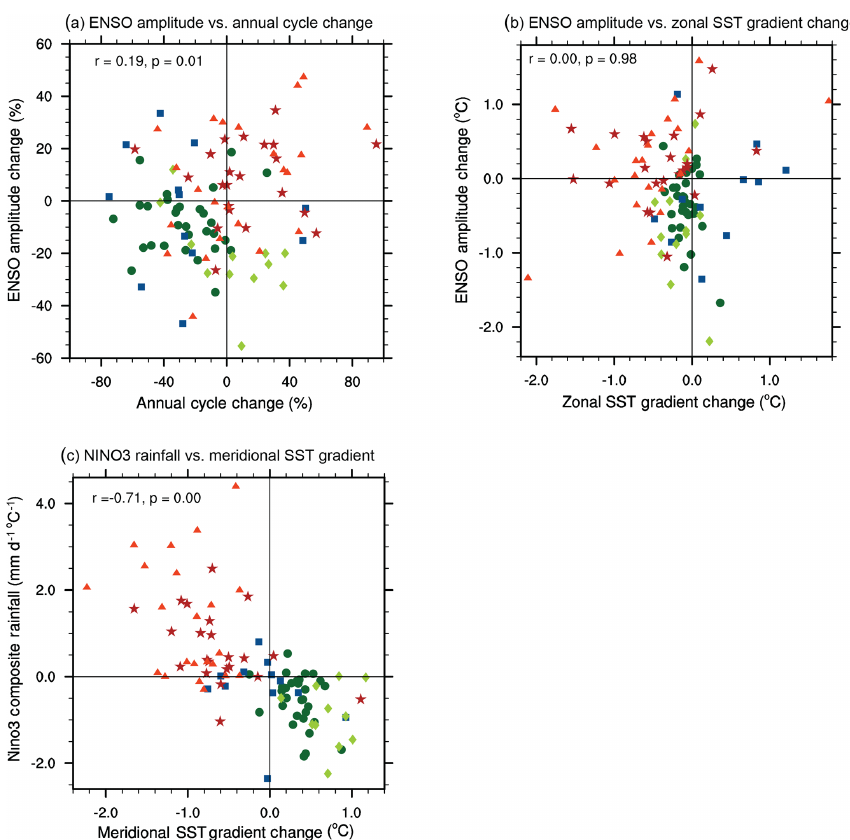
Figure 13. Relationships across all experiments and all models: (a) ENSO amplitude change (%) versus change in the annual cycle (%), (b) ENSO amplitude change ( ◦ C) versus zonal SST gradient change ( ◦ C), and (c) NINO3 precipitation for ENSO composite versus merid- ional SST gradient change ( ◦ C). All changes are relative to piControl ; see text for details. Experiments are identified as follows: blue squares indicate lgm , dark green circles indicate midHolocene , light green diamonds indicate lig127k , dark red stars indicate 1pctCO2 , and light red triangles indicate abrupt4xCO2 (after bar charts in Fig. 8). Correlation coefficients are shown for each